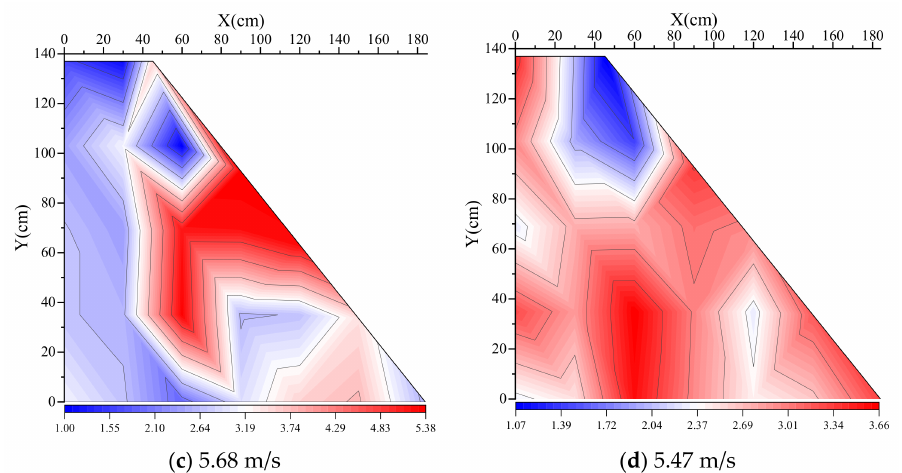
Figure 7. Bed air velocity distribution under load